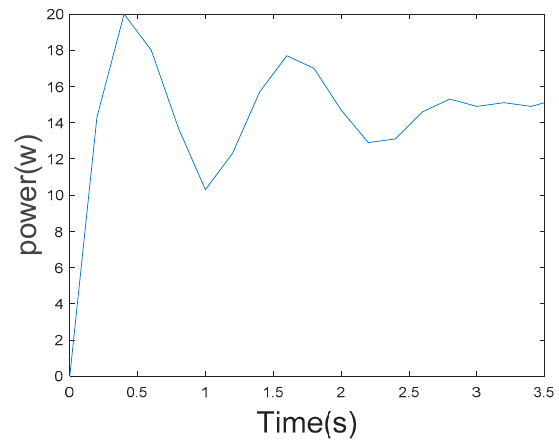
Figure 12. Power of the motion system obtained by the model.